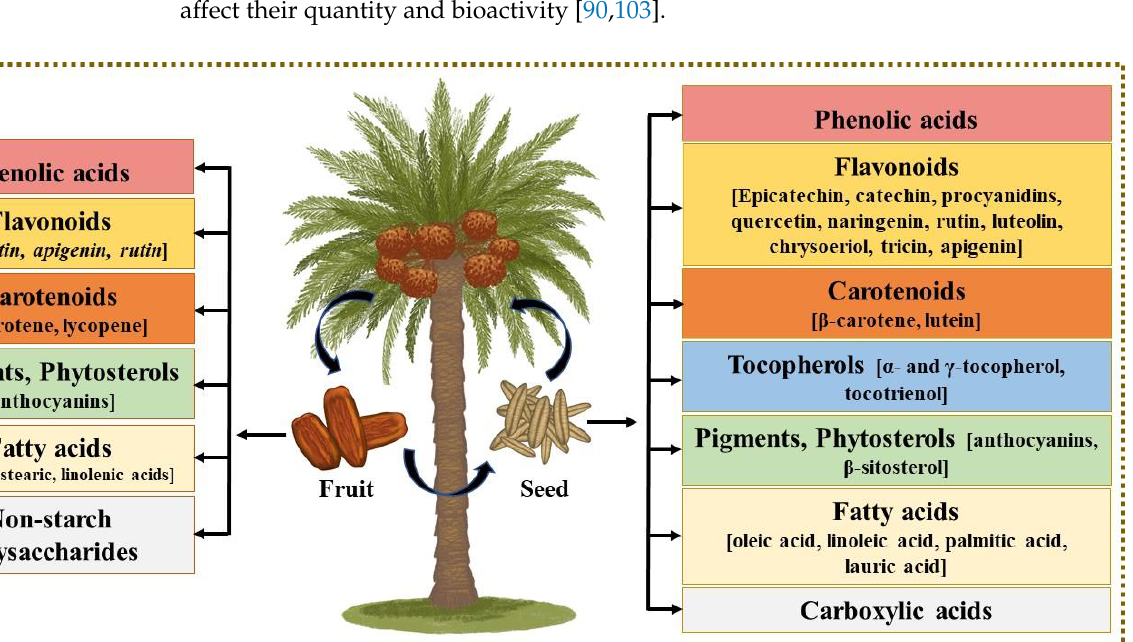
Figure 2. Bioactive constituents from date fruit and